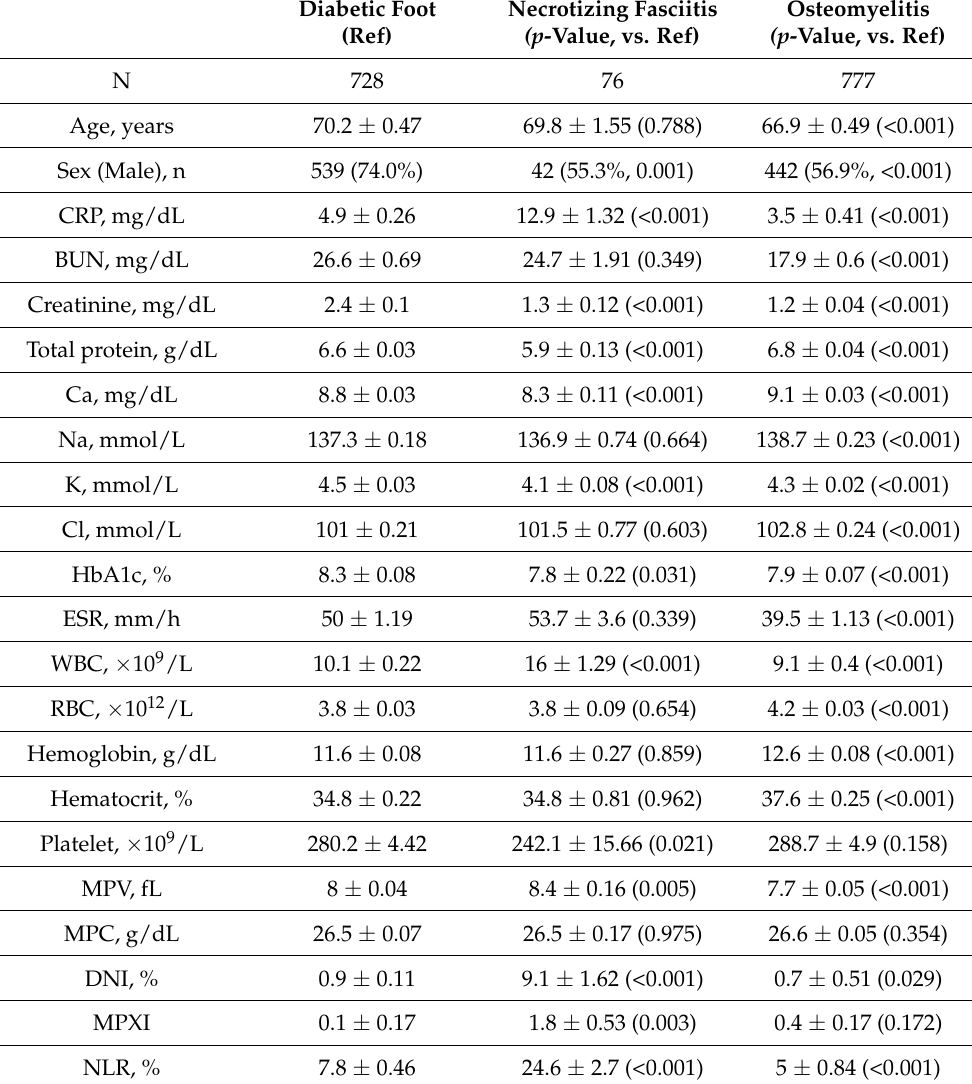
Table 1. General characteristics of diabetic foot ulcer